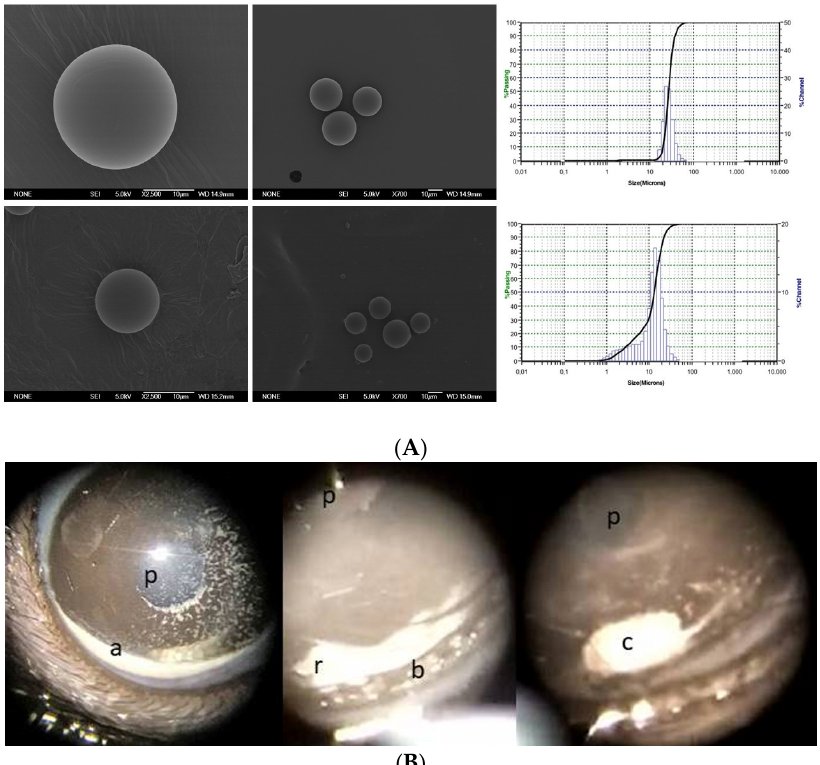
Figure 1. Visualization of microsphere (Ms) Scanning Electron Microscopy (SEM). ( A ) (SEM) images and poly (lactic-co- glycolic) acid (PLGA) microsphere particle size distribution, 38–20 µ m Ms (top); 20–10 µ m Ms (bottom) and monodisperse size distribution. Individual microspheres magnification 2500 × and group microspheres 700 × ( B ) Microsphere distribution in the anterior chamber of a rat eye during follow-up. Abbreviations: p: pupil; r: light reflex; a: microspheres at inferior iridocorneal angle; b: remnants of microspheres; c: microsphere